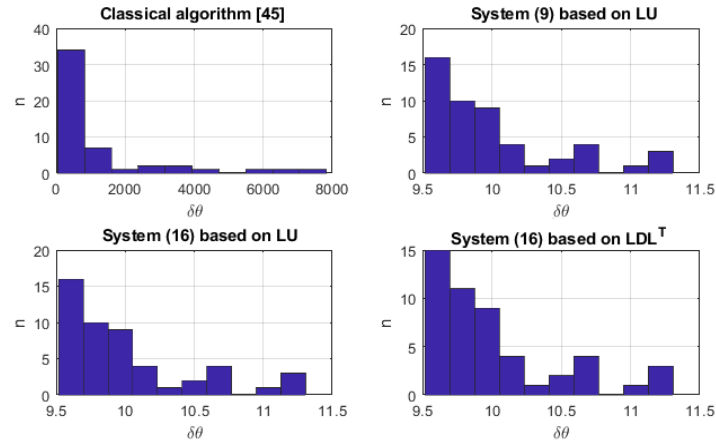
Figure 5. Normalized root mean square error of the parameters [45].